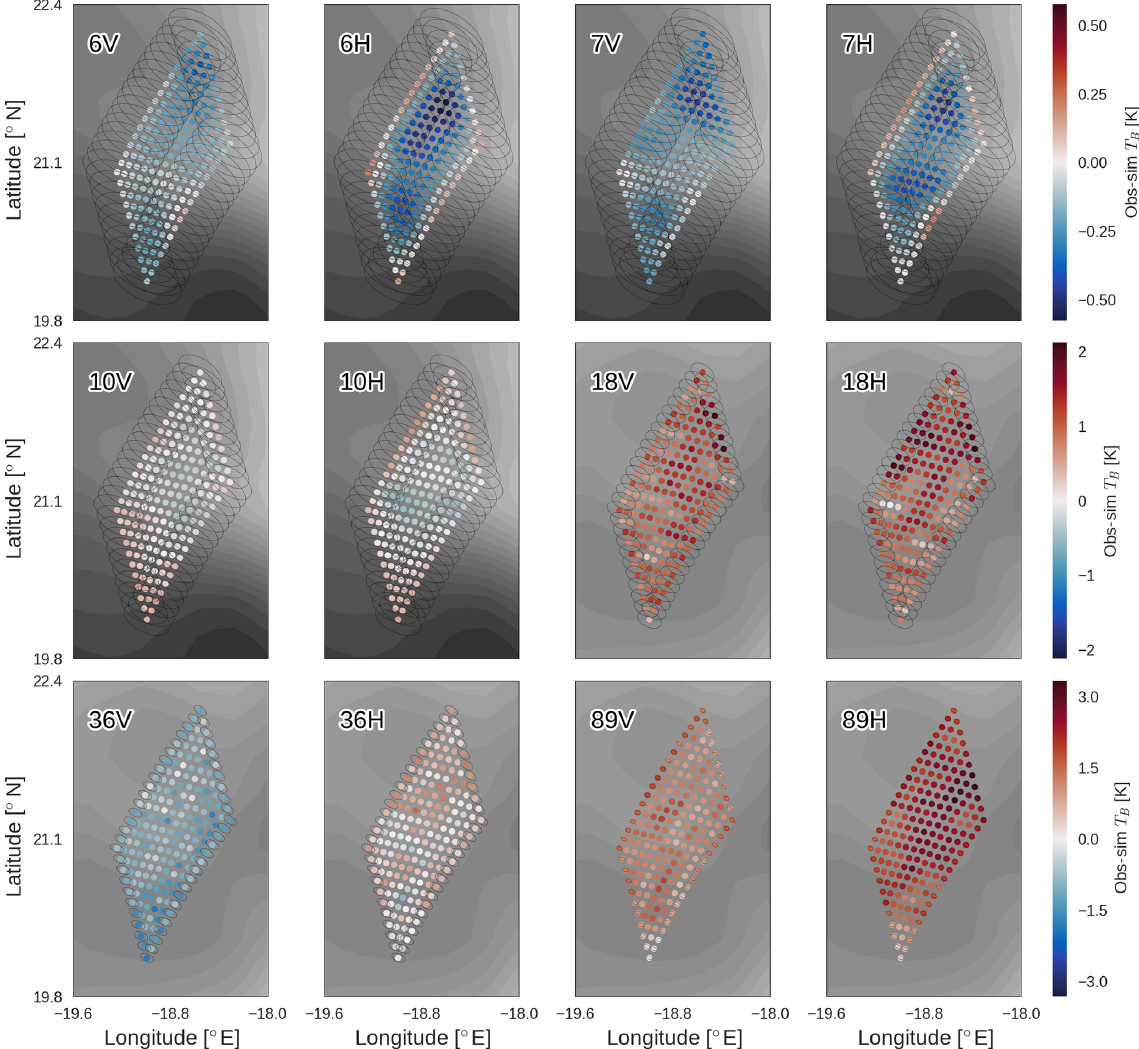
Figure 6. Observed minus simulated T B for 12 AMSR2 channels after completion of the 2D-Var retrieval, near the coast of Mauritania in the tropical Atlantic on 21 September 2016. The background shows SST in the first six panels (6–10GHz) and WSP in the last six (18–89GHz), with darker colours indicating higher values. Pixels on the edge of the measurement space are plotted along with their respective